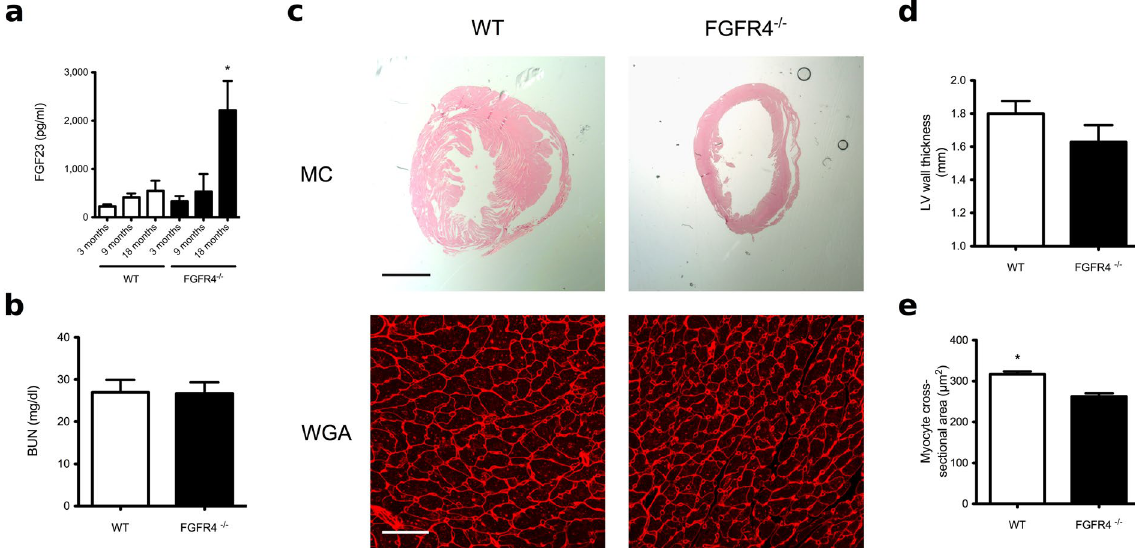
Figure 5. Aging-related LVH in mice requires FGFR4. ( a ) Serum levels of C-terminal FGF23 rise progressively in wild-type (WT) and in global FGFR4 knockout (FGFR4 − / − ) mice. At 18 months of age, FGF23 is significantly elevated in FGFR4 − / − mice when compared to WT littermates (n = 5–6 animals per group; * p < 0.05). ( b ) Blood urea nitrogen (BUN) levels are not significantly different between WT and FGFR4 − / − mice at 18 months. ( c ) Cardiac analysis of FGFR4 − / − and WT littermates at 18 months of age. Depicted are representative gross pathology mid chamber (MC) sections (scale bar 2 mm) and WGA-stained sections from the left ventricular mid-chamber free wall (scale bar 50 µ m). ( d ) WT mice exhibit a tendency towards increased left ventricular (LV) wall thickness. ( e ) WT mice manifest significant increases in cross-sectional area of individual myocytes (n = 100 cells/animal: 5–6 animals per group; * p <